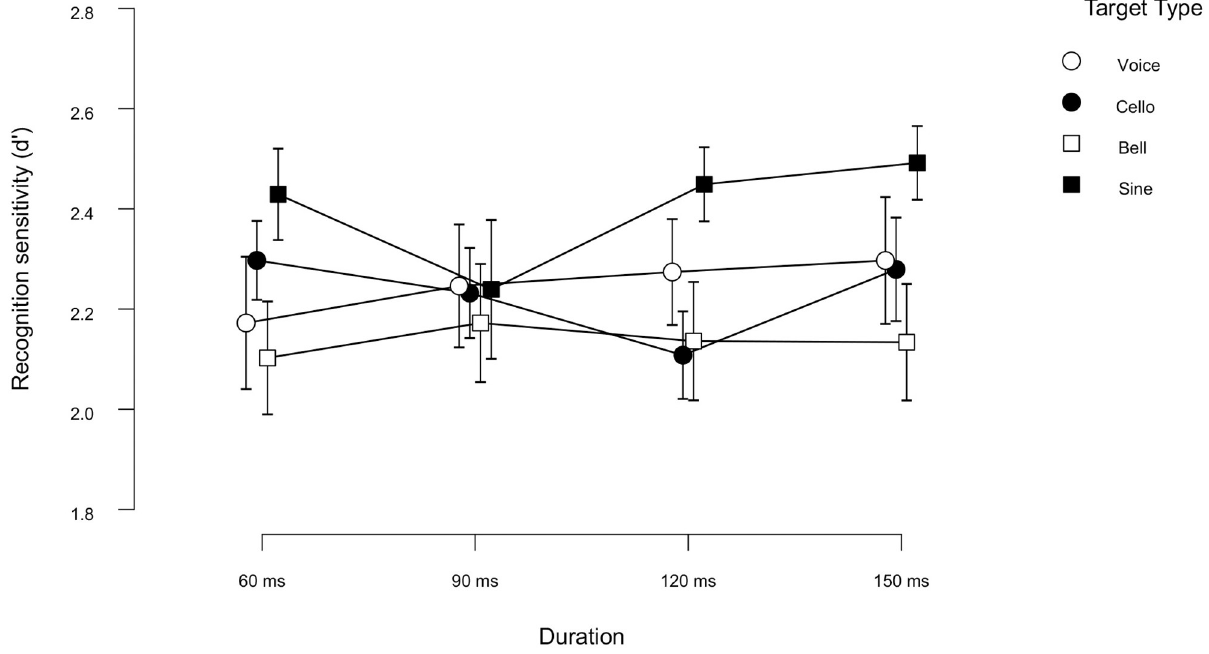
Fig 1. Target recognition sensitivity ( d ’) plotted as a function of duration (in Exp1a). Open circles, closed circles, open squares, and closed squares represent the data under the voice, cello, bell, and sine tone conditions, respectively. Error bars represent the standard error of the mean.